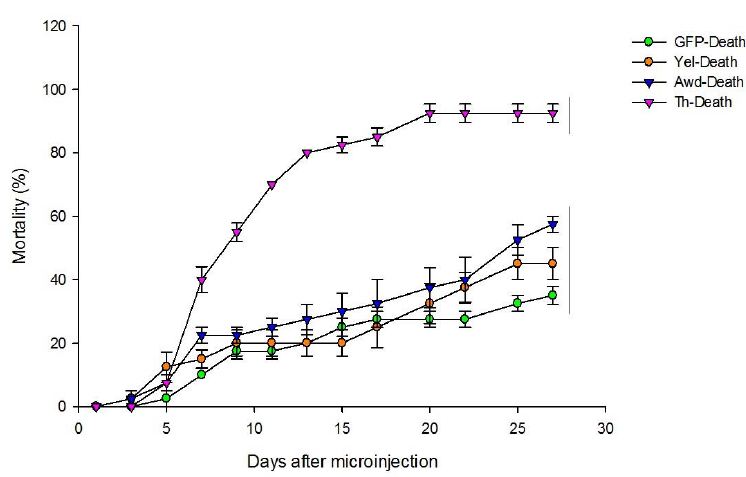
Figure 2. Cumulative mortality of E. heros after microinjection of dsRNA targeting awd , th and yel in 3rd ‐ instar nymphs. ds GFP was used as a control. The curves encompassed by the same vertical bar at the right side of the plot are not significantly different according to Holm ‐ Sidak’s test ( p > 0.001). The assay was conducted with two replications each consisting of 20 nymphs ( N = 40).